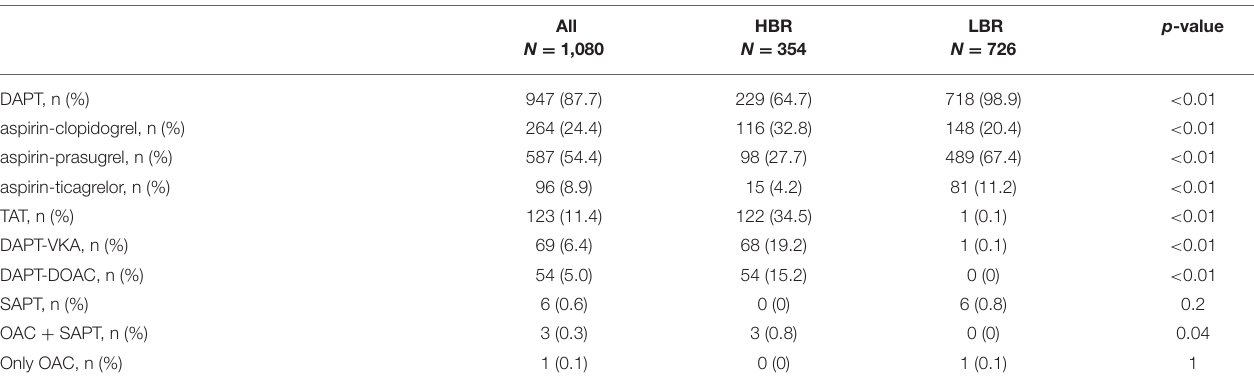
TABLE 3 | Antithrombotic regimen at hospital